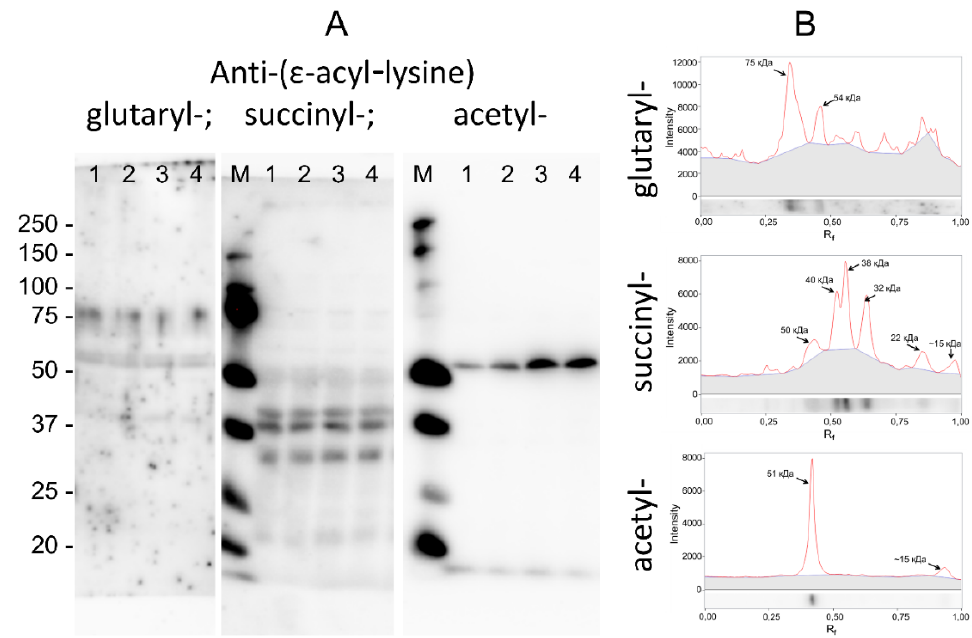
Figure 5. Visualization of glutarylation, succinylation and acetylation of proteins of the brain cortex of the male rats aged 10–12 weeks. Proteins were separated by SDS-PAGE and visualized on the membrane using the obtained antibodies against ε -glutaryl-lysine (0.8 µ g/mL) and commercial antibodies against ε -succinyl-lysine (0.5 µ g/mL) and ε -acetyl-lysine (0.29 µ g/mL). ( A ) Immunoblotting of the cerebral cortex samples from male rats; 1–4—different animals; M—protein markers with known molecular weights indicated to the left of the blots. ( B ) Densitograms of the results of immunoblotting with automatically determined molecular weights of the major protein bands.